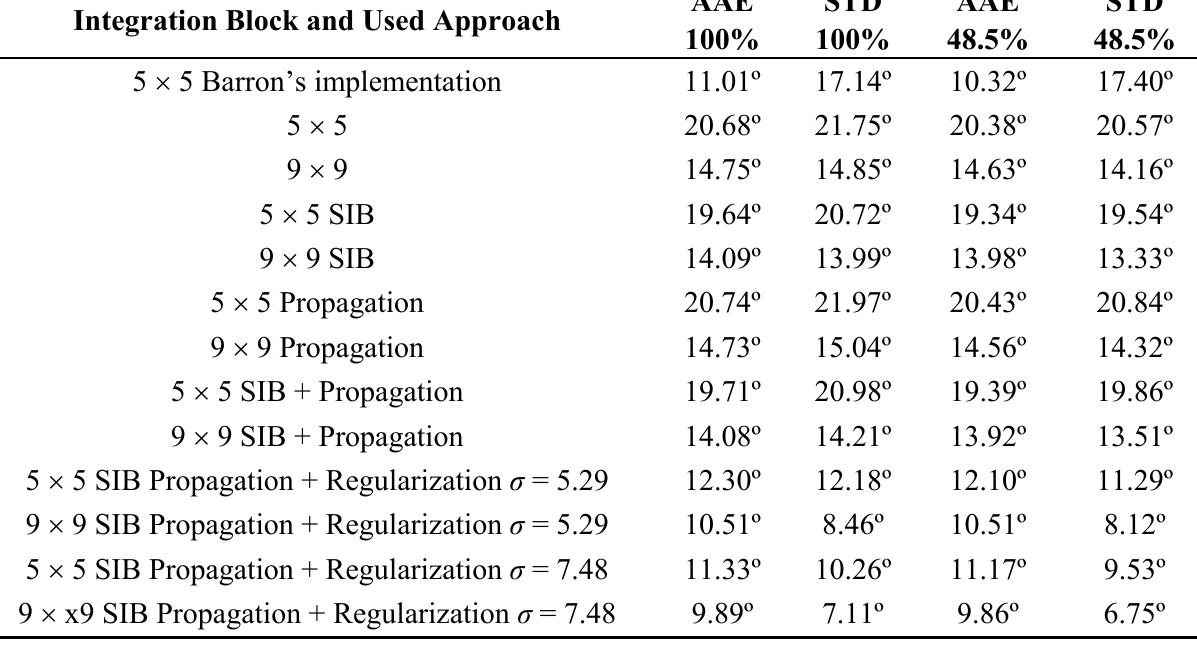
Table 2. Average angular error (AAE) and standard deviation (STD), in Yosemite sequence (without clouds), with the different proposed approaches and densities on Matlab. Integration Block and Used